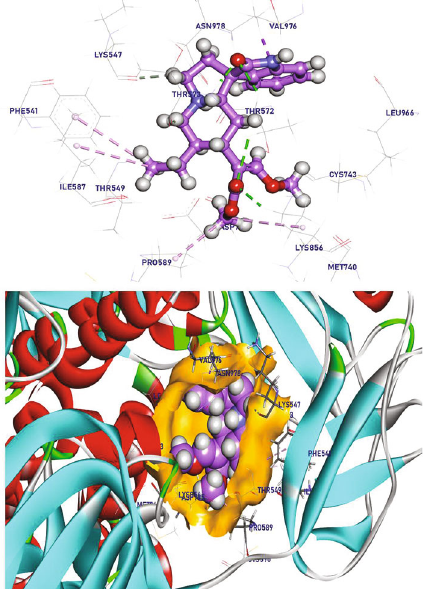
Figure 9: Isorhynchophylline docked in RBD-SARS-CoV-2 Omicron spike protein, hydrogen bonds (green), and the pi interactions are represented in purple lines.